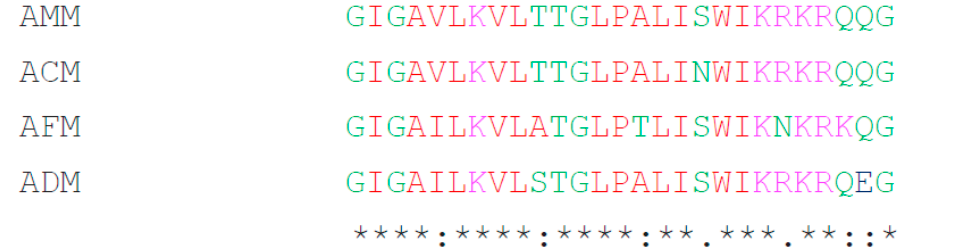
Figure 1. Multiple sequence alignment of melittin peptides from four honey bee species via MUSCLE. An asterisk (*) indicates highly conserved sites, and a colon (:) and dot (.) represent less-conserved sites.